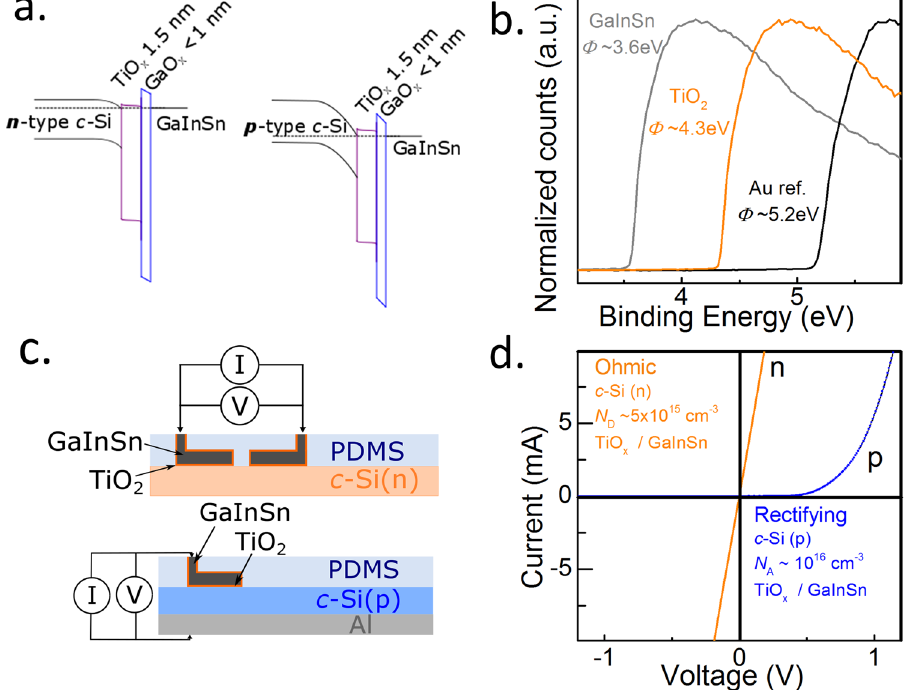
Figure 4. Carrier-selective contacts within the microchannel. ( a ) Idealized band structure of TiO x /GaO x / GaInSn electron contacts, ( b ) XPS secondary electron cutoff energy showing work function of GaInSn and TiO x layers alongside Au reference. ( c ) Test structure diagrams of microchannel electron selective contacts made to n-type (top) and p-type (bottom) silicon wafers. ( d ) IV behavior of selective contact structures shown in ( c